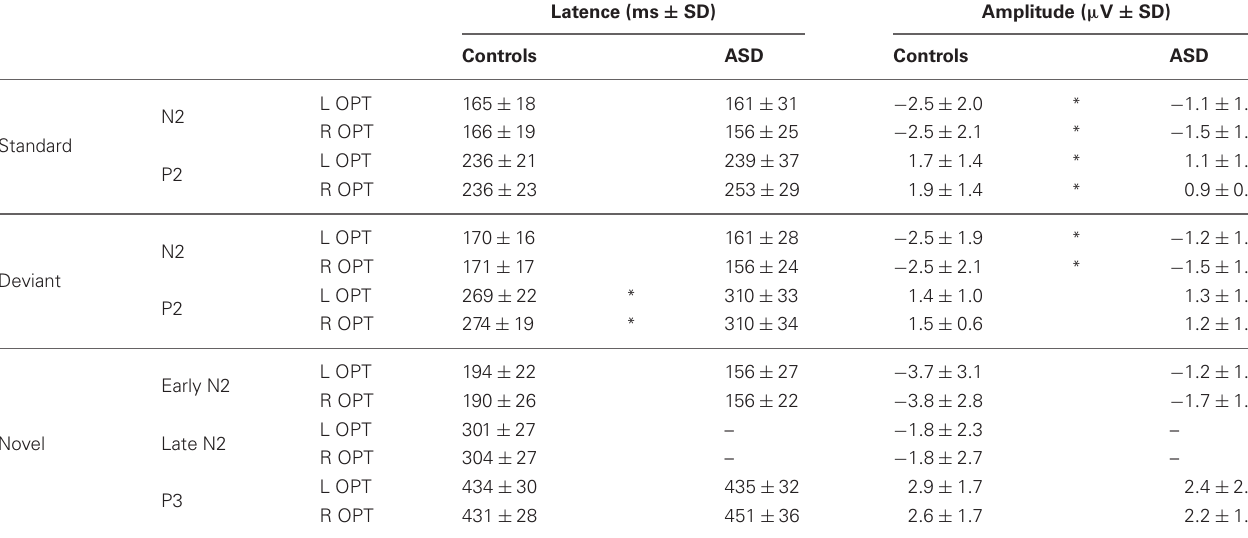
Table 1 | Mean amplitudes and latencies of the responses to standard, deviant, and novel visual stimuli in each